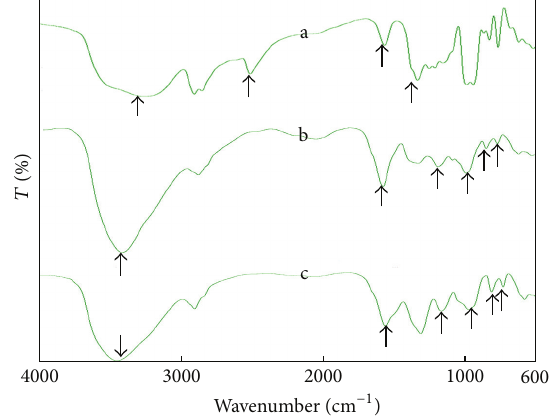
Figure 3: FT-IR spectra of (a) CdTe-TGA QDs, (b) salep-g-PAA, and (c) CdTe- salep-g-PAA QDs.